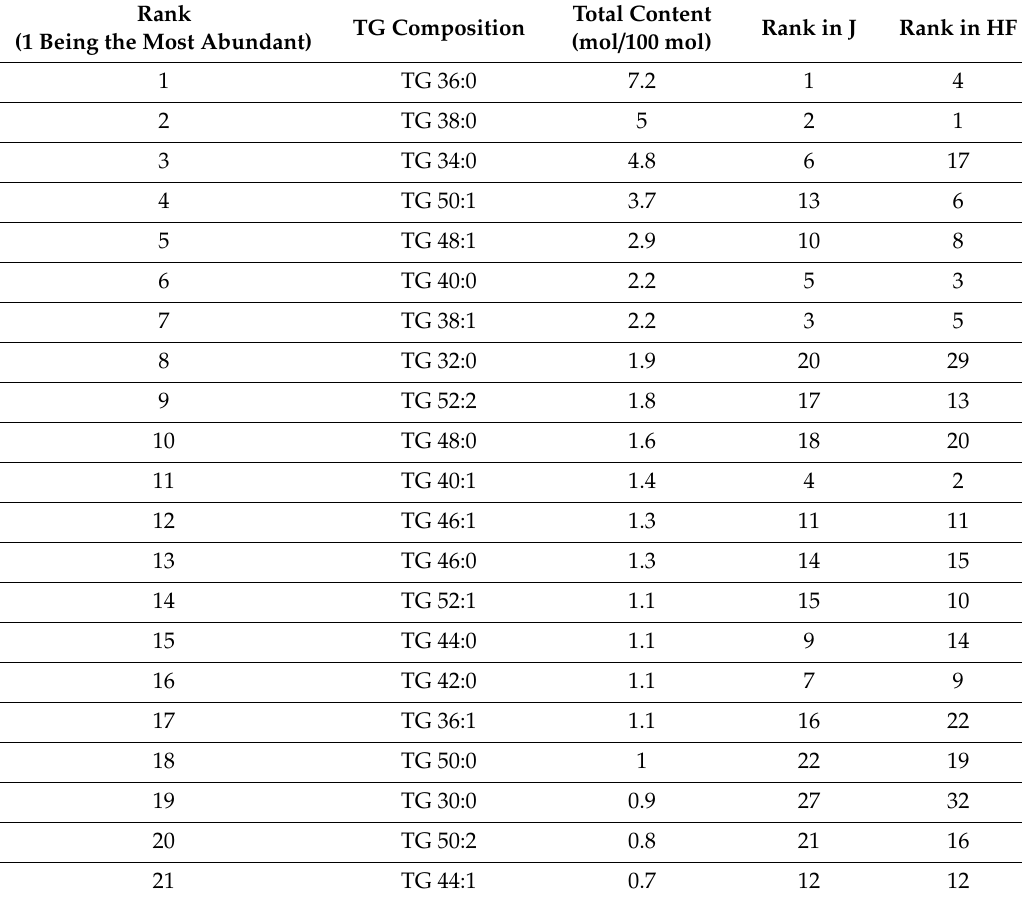
Table 4. The list of 21 lipid compositions and their content in the bovine milk adapted from that list of individual TG species [34]. The reported lipid compositions were detected in both the groups as the top 32 most abundant lipid